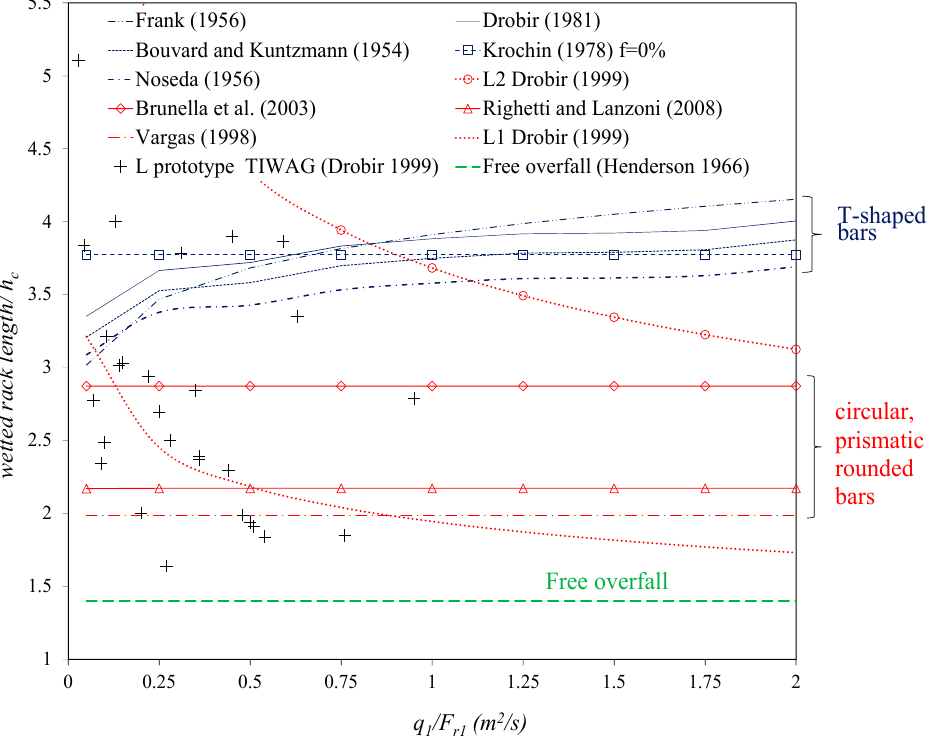
Figure 1. Dimensionless wetted rack lengths as a function of critical flow depth of approaching, h c , proposed in literature for racks with void ratio m = 0.60 and 20% of slope.